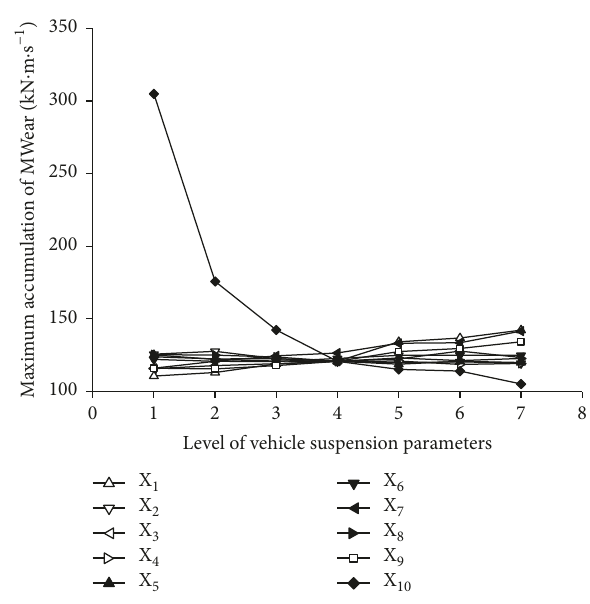
Figure 3: Influence of vehicle parameters on the maximum wear power